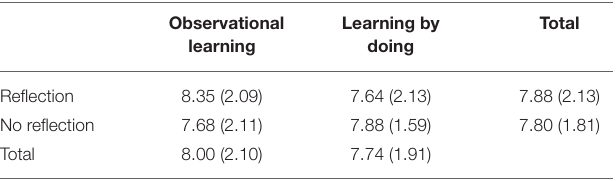
TABLE 6 | Average Academic Writing Performance (SD) in relation to Instructional Method and Reflection (min. score 0, max. score 15). Observational learning